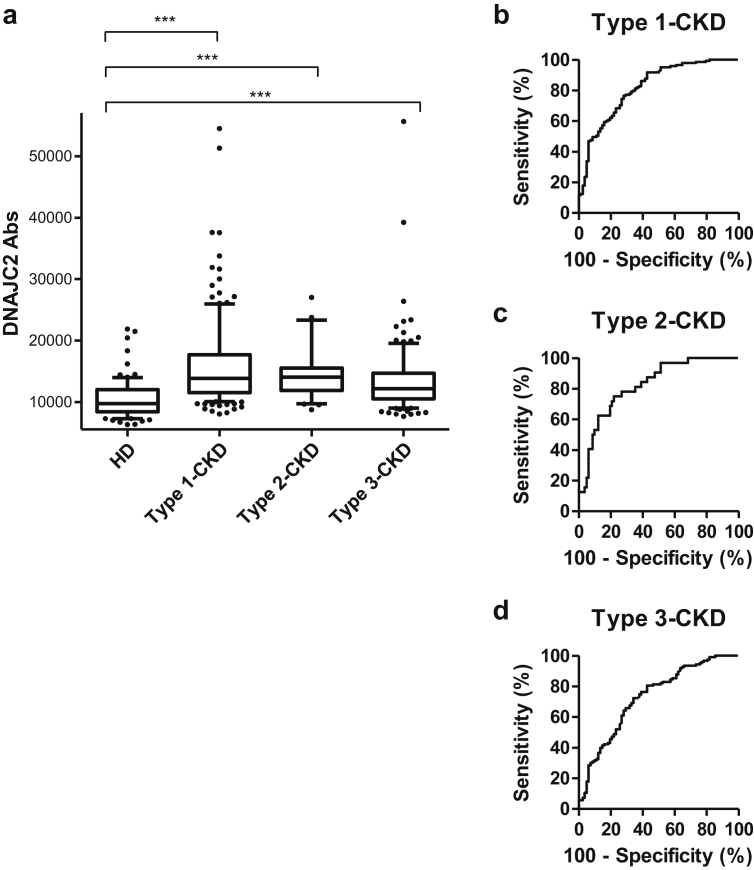
Association between DNAJC2-Ab levels and chronic kidney disease (CKD). (a) Serum DNAJC2-Ab levels of the HDs and the patients with CKD are shown as box-whisker plots, as described in the legend of Figure 2. CKD patients were divided into three groups: type 1, diabetic kidney disease; type 2, nephrosclerosis; and type 3, glomerulonephritis. The mean age (±standard deviation) of the HDs and the patients with type 1, 2, and 3 CKD were 45.82 ± 11.66, 65.78 ± 10.28, 75.97 ± 9.94, and 66.05 ± 14.60 years, respectively. Results of the ROC analysis of DNAJC2-Abs to detect type 1, 2, and 3 CKD (b–d) are also shown. ∗∗∗p < 0.001 by the Mann–Whitney U test with type I error adjustment using the Bonferroni procedure.